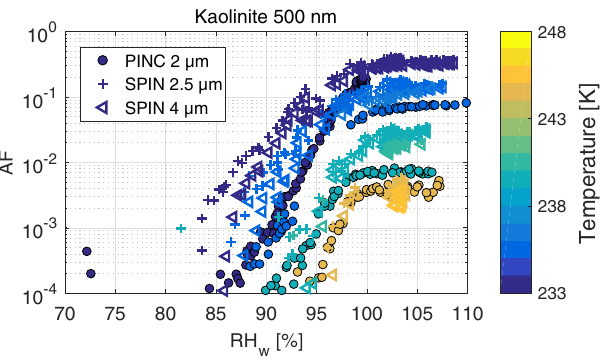
Figure 7. PINC and SPIN RH scans for size-selected kaolinite par- ticles. PINC data are analyzed with an ice crystal size threshold of 2µm. SPIN data are presented with the used ice threshold size of 2 . 5µm and a larger one of